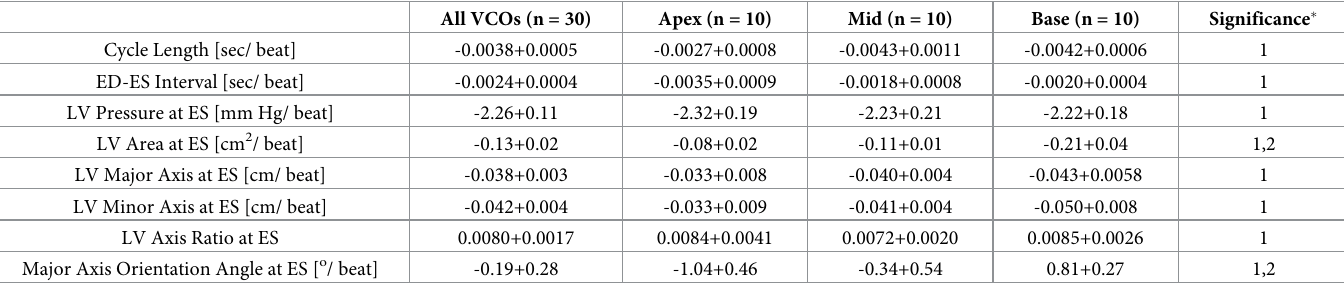
10.76 and the computation time for automatic segmentation was less than 10 seconds per slice. The intra-observer variability from the two readers were 0.54% and 0.88%. The Dice similarity coefficient between level set segmentation and manual segmentation by two readers was deter- mined to be 87.31% ± 2.51% and 88.13% ± 3.43% respectively thus demonstrating high LSSPM accuracy as shown in Fig 3B . A representative LV area vs time plot is shown in Fig 4 . Cardiac cycle timing and pressure Cycle length, ED-ES interval and LV pressure at baseline are seen in Table 1 . The average baseline sheep heart rate is 94.19 bpm. The ED-ES interval was significantly shorter at the mid ventricle level (0.246+0.005 sec) than at the apical level (0.261+0.005 sec) but the cardiac cycle length was not different between LV levels. At baseline, the LVP was significantly lower at the apical level (88.6 ± 1.60 mm Hg) than both the mid-ventricle and basal levels (94.8 ± 1.34 and 95.1 ± 1.40 mm Hg respectively). Changes in cycle length, ED-ES interval and LV pressure during VCO are seen in Table 2 . There was statistically significant shortening of both the ED-ES interval (-0.0038+0.0005 sec/ beat) and cardiac cycle length (-0.0024+0.0004 sec/ beat) during VCO. For reference, this is a 4.8 msec decrease in cycle length over a 20 beat VCO. The rate of change of LVP during VCO was not different between LV levels. Table 2. VCO cardiac MRI